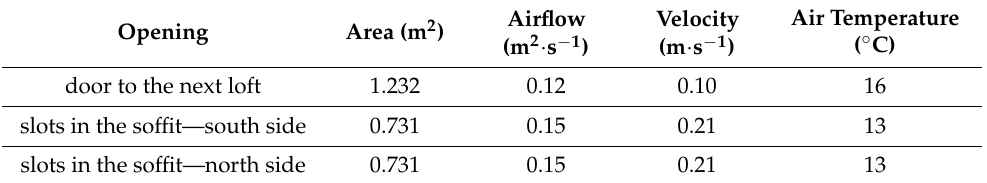
Figure 15. Simulated course of the volume flow rate through the opening towards the tower. Table 7. Airflow characteristics through the openings at 2:00 a.m. obtained from BPS simulation.